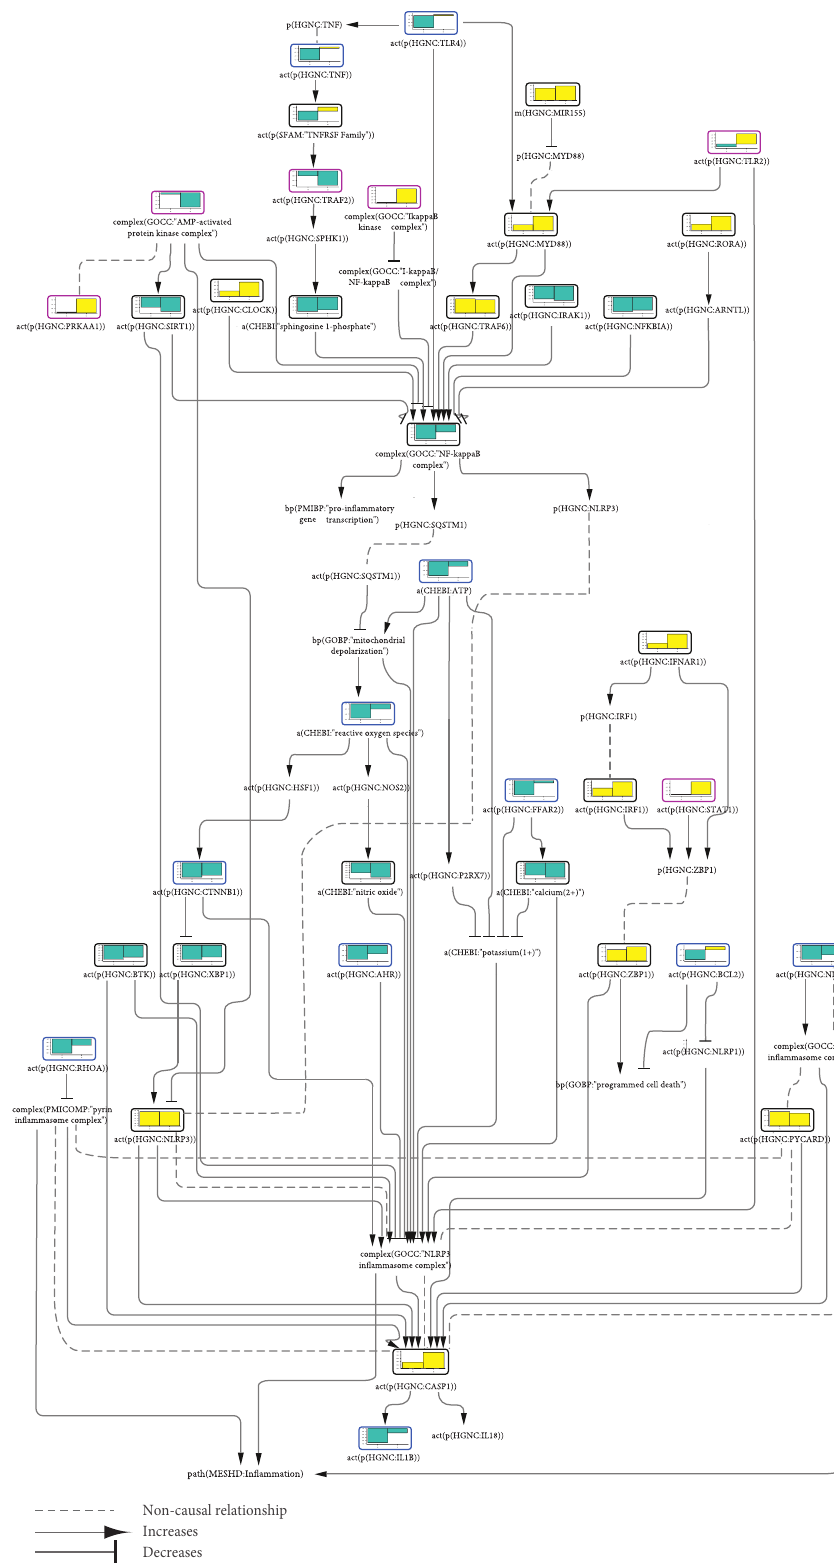
Figure 2: Part of the inflammasome network model scored with transcriptomic data from GSE55235. The bar graph above each node, which was scored, shows the inferred fold change in the synovial tissues of (1) osteoarthritis (OA) and (2) rheumatoid arthritis (RA) patients relative to healthy subjects. The directionalities are shown as yellow or blue bars for inferred upregulation or downregulation, respectively. The black outline refers to nodes that were significantly impacted in both diseases, the blue outline refers to nodes that were significantly impacted only in OA, and the purple outline refers to nodes that were significantly impacted only in